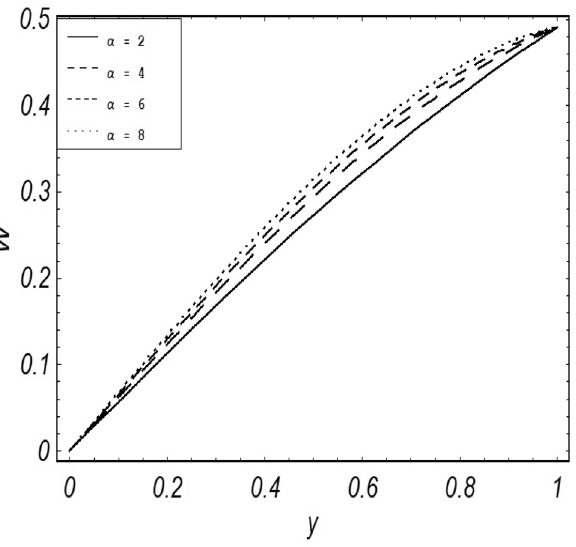
Figure 14. Evolution of W with various values of α if t = 1 ; Gr = 2.5 ; K = 0.5 ; N = 1 ; η = 0.2 ; m = 0.5 ; � = 0.5 ; Re = 1 ; M = 0.5 ; ω = 0.5 ; ε = 0.001